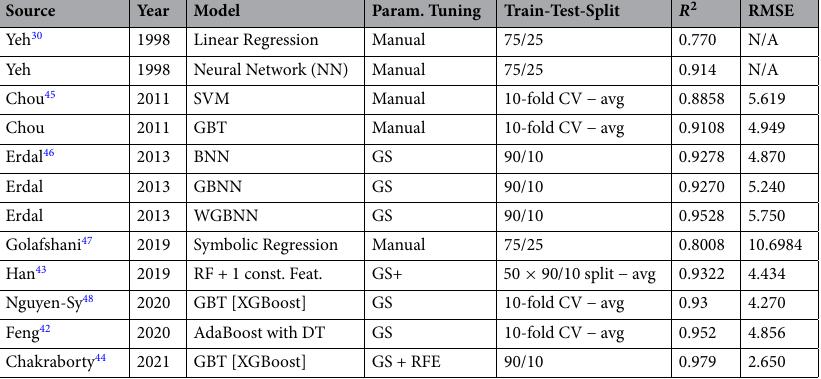
Table 2. Overview of the literature using the UCI-concrete dataset. SVM (Support Vector Machine), GBT (Gradient Boosted Trees), BNN (Bagged NN), GBNN (Gradient Boosted NN), WBNN (Wavelet Bagged